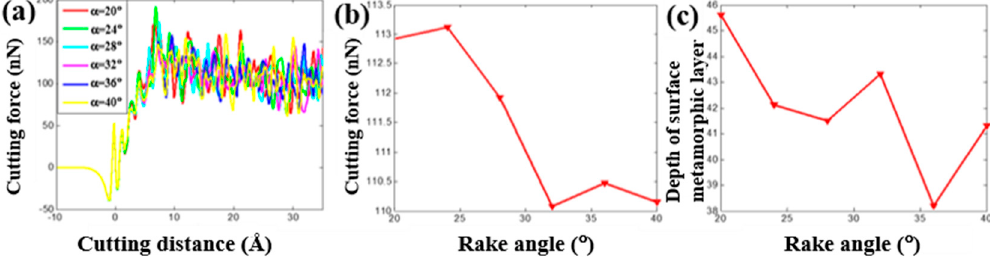
Figure 10. The cutting force and depth of the surface metamorphic layer obtained from MD by varying the tool rake angle. ( a ) Cutting force vs. the cutting distance under di ff erent tool rake angles α ; ( b ) evolution of the average cutting force when varying the tool rake angle and ( c ) evolution of the depth of the surface metamorphic layer when varying the tool rake angle.